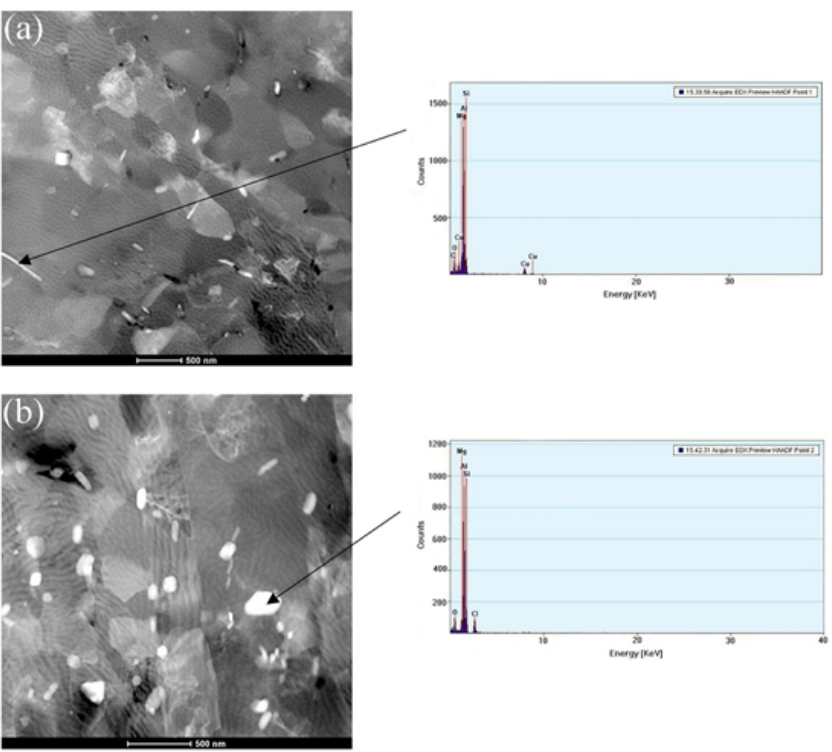
Figure 9. The TEM images showing the secondary phase of 6061 aluminum alloy in the deformed state processed by MEM and MEM-MEM and the corresponding EDS spectra of the elementary composition of secondary phase. ( a ) MEM; ( b )